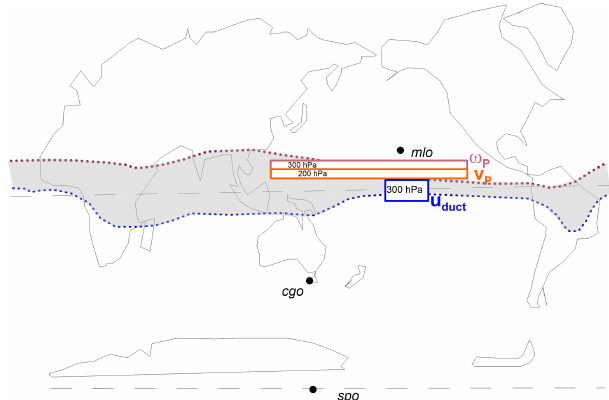
Figure 5. Schematic of the boundaries and altitudes of regions used in FF18 to define wind indices that describe eddy IH transfer ( u duct , westerlies positive) and mean transfer (uplift, negative ω P ) and north-to-south transfer (negative v P ). The shaded area brackets the austral summer extent of the Intertropical Convergence Zone in the south (blue dash) and boreal summer extent in the north (red